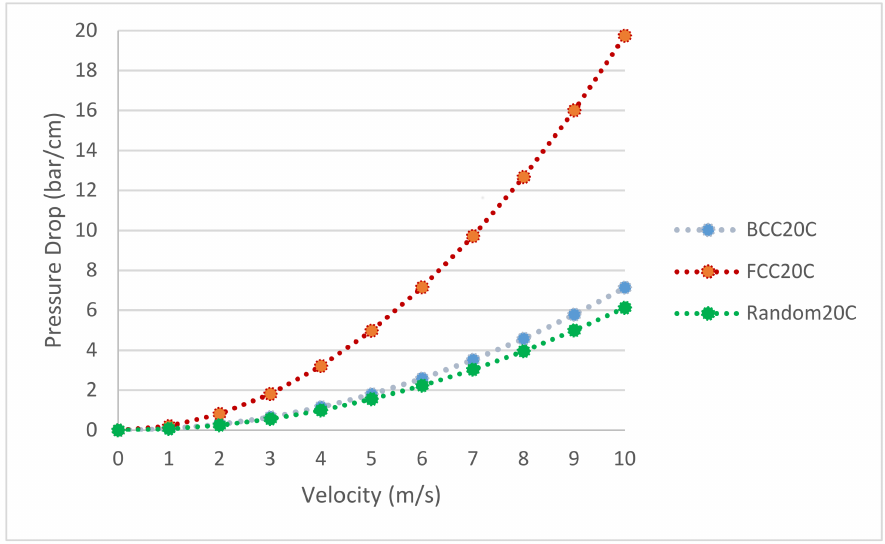
Figure 16. Pressure drop as a function of velocity for water at three bed structures with 15 mm spheres.